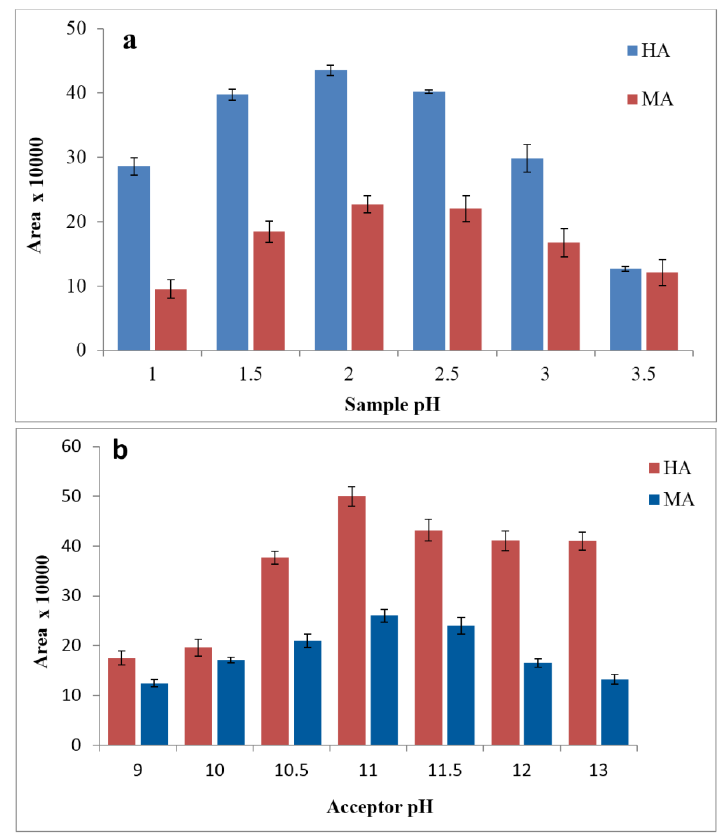
Figure 2. Effects of sample pH ( a ) and acceptor pH ( b ) on extraction efficiency of HA and MA by HF-LPME. Extraction conditions: 10 mL aqueous sample solution of 1 mg·L −1 metabolites organic